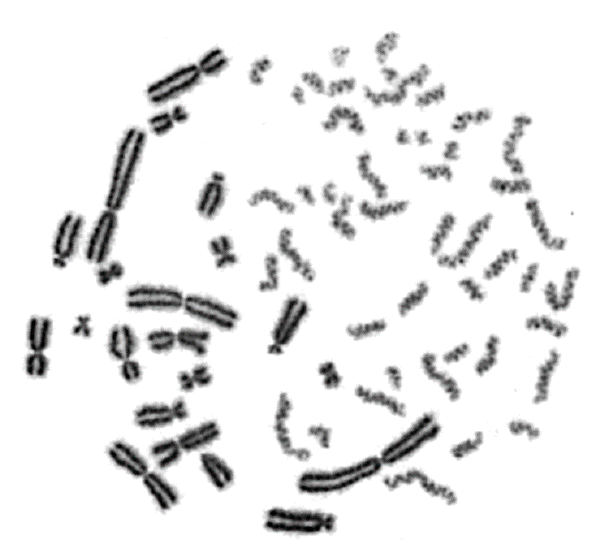
Figure 1. Representative image of a non-irradiated peripheral blood G0 lymphocyte exhibiting 46 lightly stained single chromatid prematurely condensed chromosomes (PCCs) obtained by fusion with a mitotic Chinese Hamster Ovary (CHO) cell. The stable number of 46 PCCs in non-irradiated peripheral blood lymphocytes from healthy donors represents a clearly detectable interphase cytogenetic endpoint. In fact, it allows quantification of radiation-induced DNA lesions, as reflected at the level of interphase chromosomes by means of excess (over 46) PCC fragments.